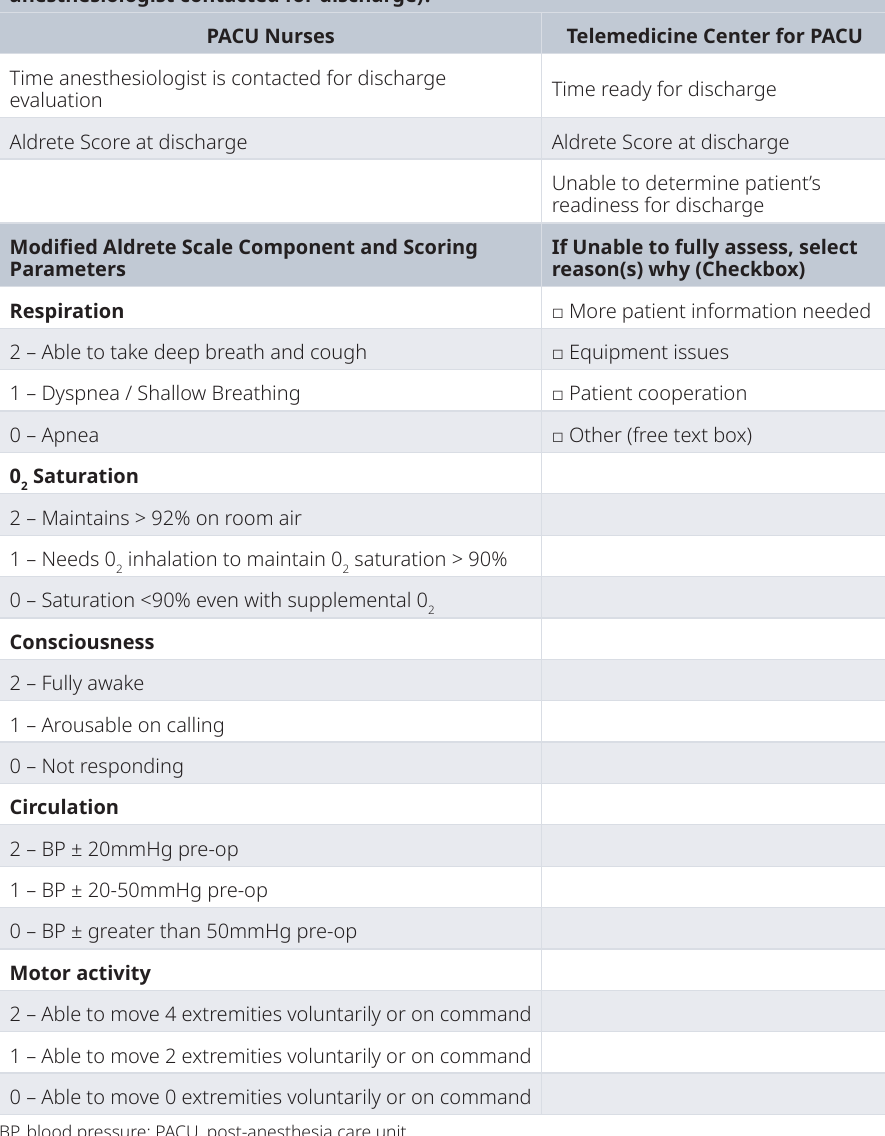
Table 5. Patient discharge